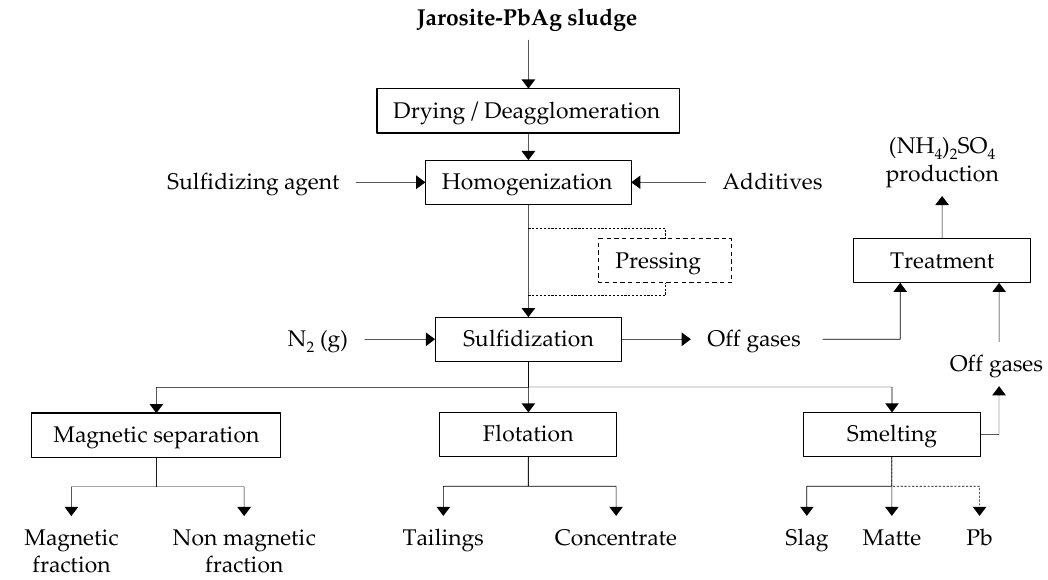
Figure 1. The flowsheet of experimental process.